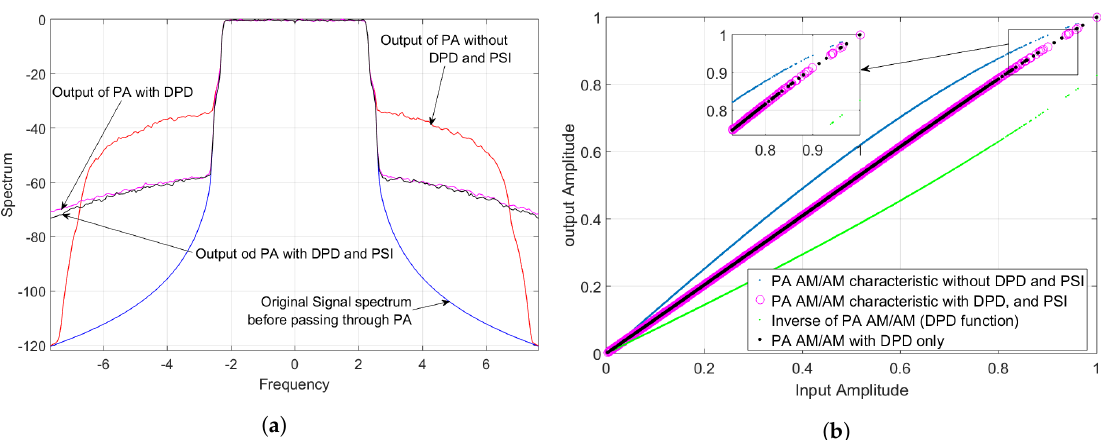
Figure 18. ( a ) Spectrum of PA output signal with and without DPD, and PSI technique (FPGA test). ( b ) PA AMAM characteristic with and without DPD, and PSI technique (FPGA